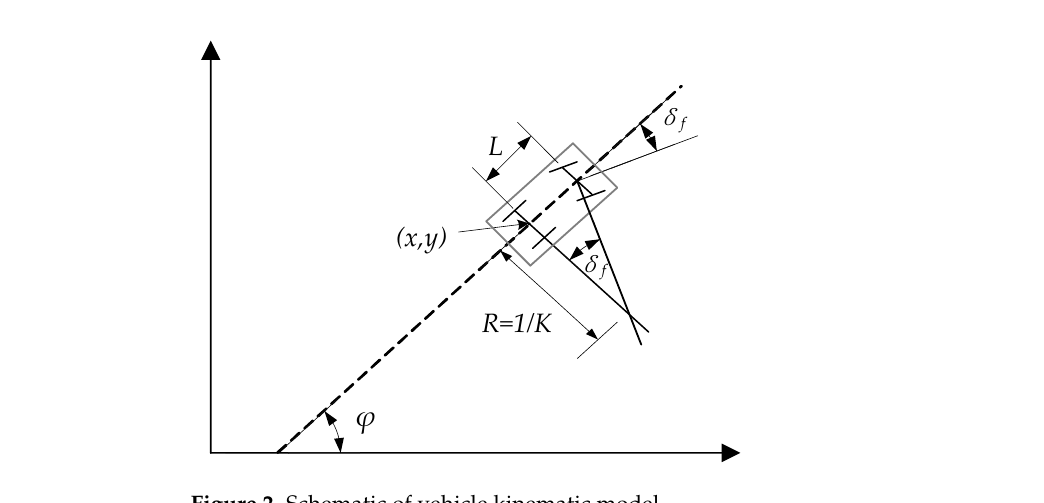
Figure 2. Schematic of vehicle kinematic model.